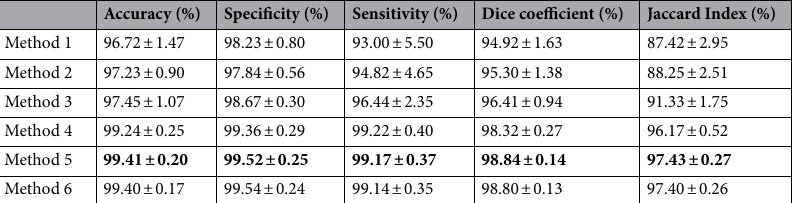
Table 4. Lung segmentation results on the Haut dataset (mean ± standard deviation). Significant values are in